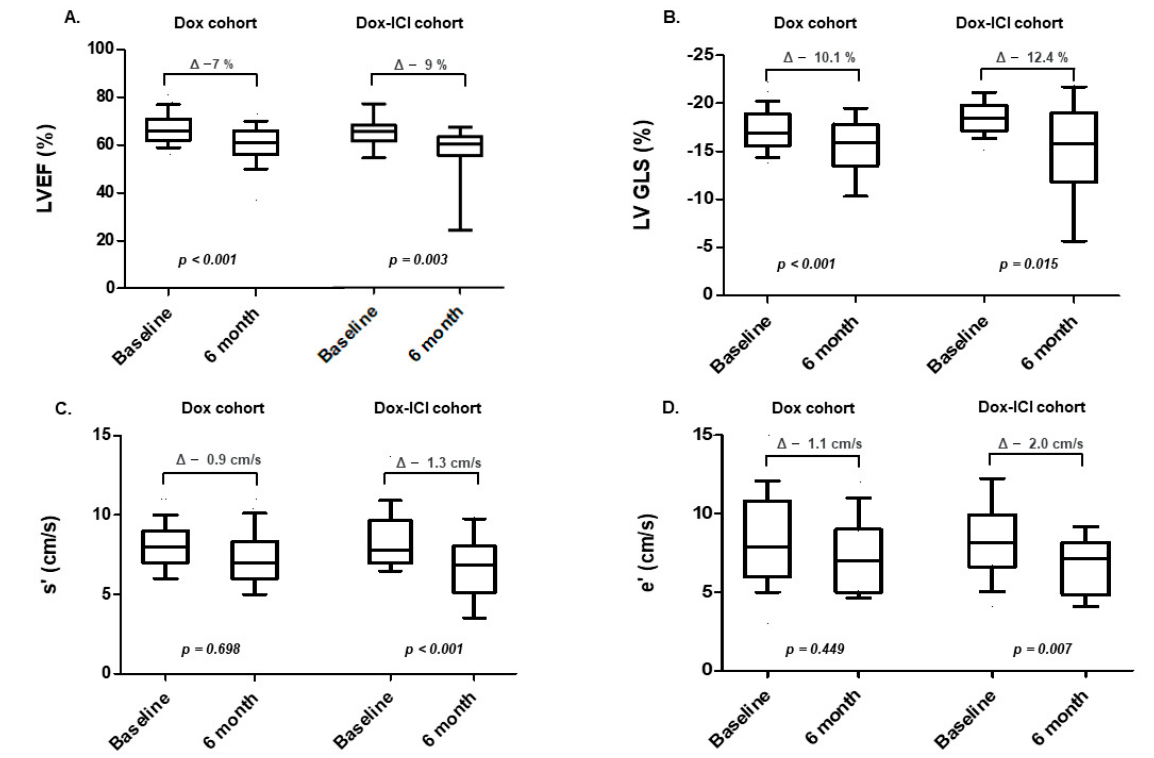
Figure 2. Changes in echocardiographic parameters after chemotherapy. ( A , B ) reveal that LVEF and LVGLS were significantly reduced after chemotherapy in both cohorts. ( C , D ) show that tissue Doppler imaging velocities (S’ and e’) were significantly decreased in the Dox-ICI cohort, but not in the Dox cohort.